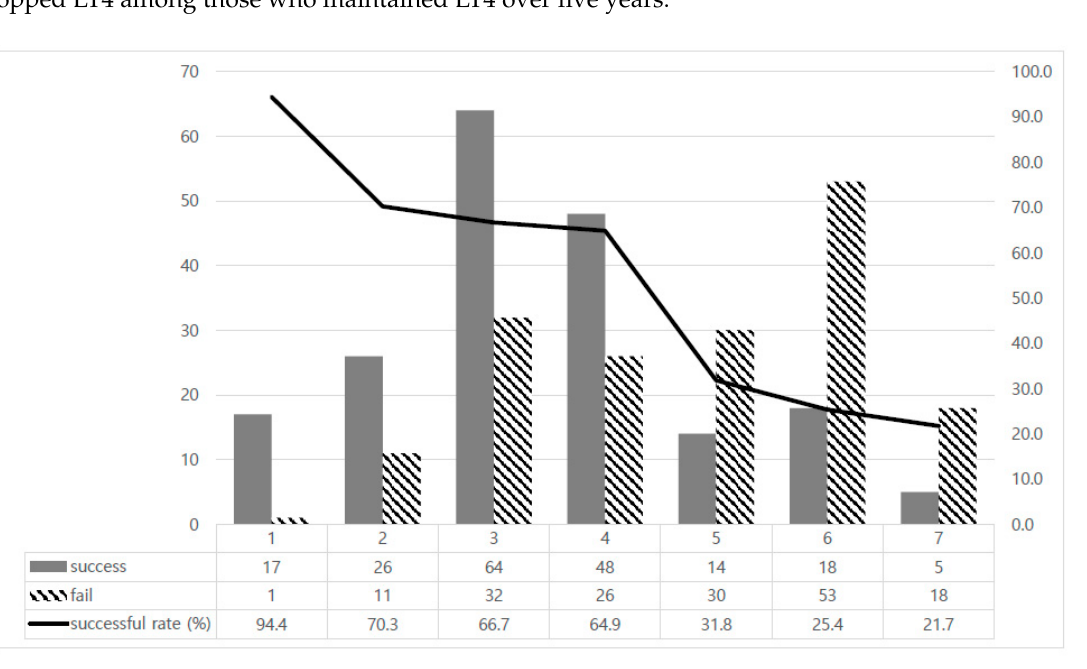
Figure 2. Success rate of levothyroxine cessation according to timing.